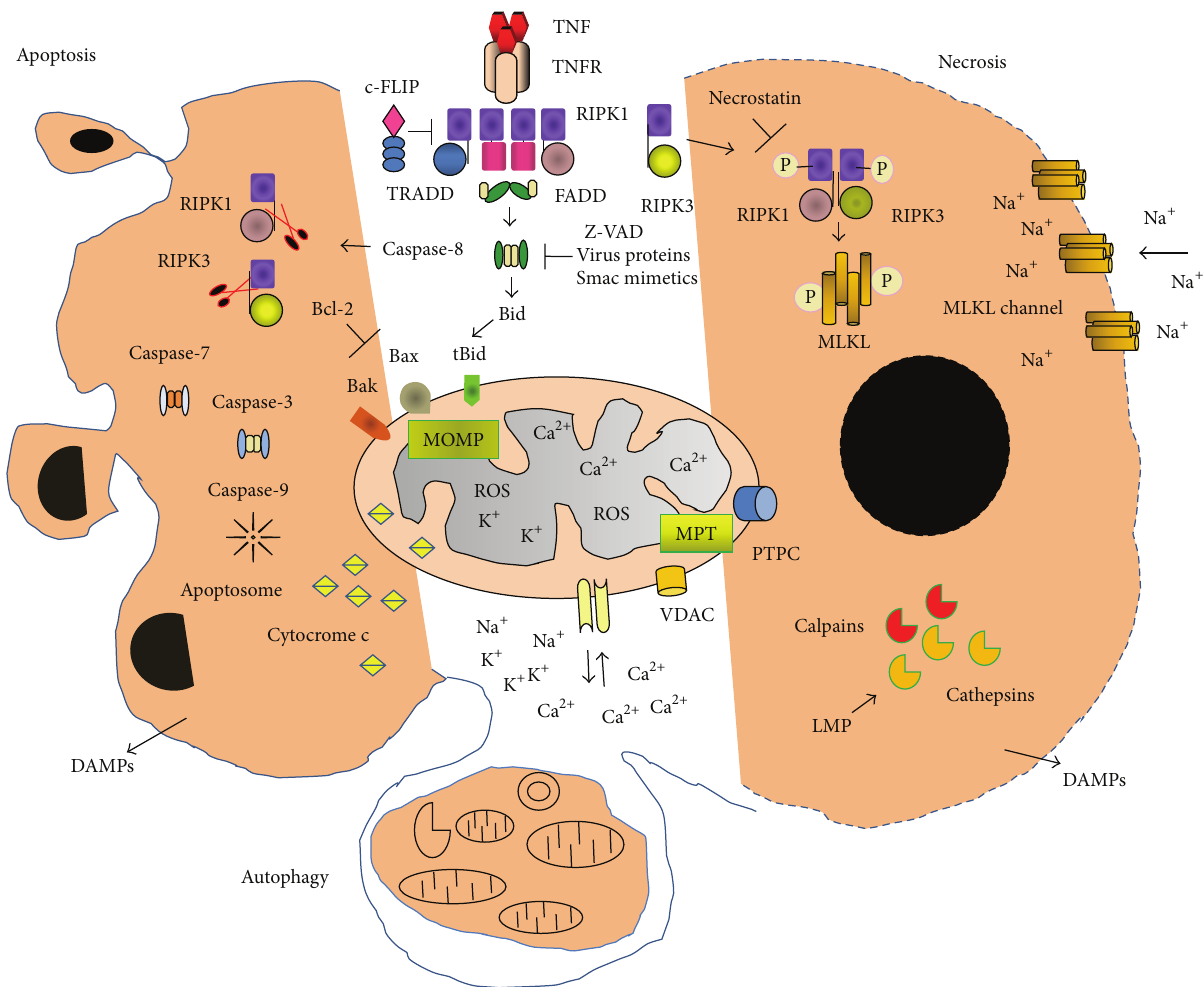
Figure 2: Schematic overview of the multiple signaling pathways to apoptosis, necroptosis and autophagy. TNF- 𝛼 binding to TNFR causes the assembly of a membrane-proximal supramolecular complex including (but not limited to) TRADD, FADD, and RIPK1 (receptor interacting protein kinase 1). Recruitment and activation of caspase-8 play a crucial role in initiation of apoptotic or necrotic cell death. Active